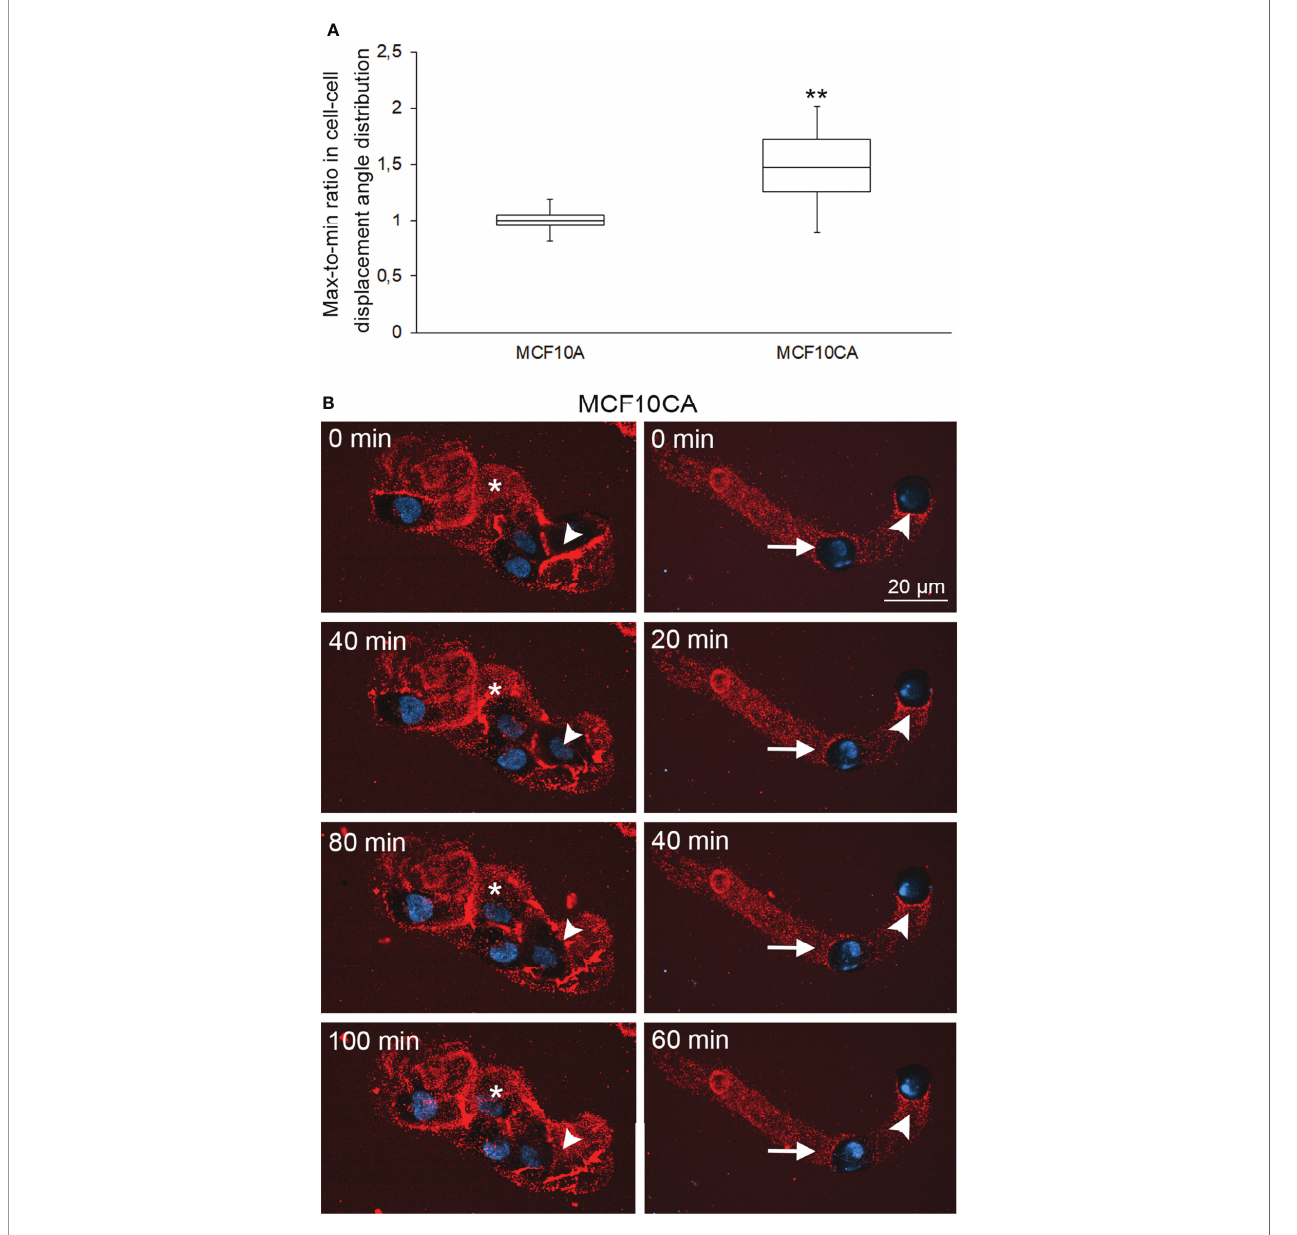
FIGURE 5 | Collective cell motion is more coordinated in cancer cells than in normal cells. Whisker and box plot showing the distribution of correlation index (CI) for MCF10A (left) and MCF10CA (right) cells (A) . Plots were constructed using data from 11 FOVs from 2 experiments for each cell type, totalizing several hundreds of cells. The CI of each FOV was normalized to the median CI of normal cells for the same experiment. **: Wilcoxon rank-text p-value p=0.0151. Two examples of collective migration of live MCF10CA cells along trails are shown in (B) . Asterisks (*) indicate the hyaluronan-rich area that the migrating cell follows, and arrowheads show the trail that a moving cell leaves behind (left panel in B and Supplementary Movie 2 ). The right panel in B and Supplementary Movie 2 show an example of leader-follower behavior, where the original position (0 min) of the leader cell is indicated by an arrowhead and the follower cell by an arrow. Red = hyaluronan and blue =